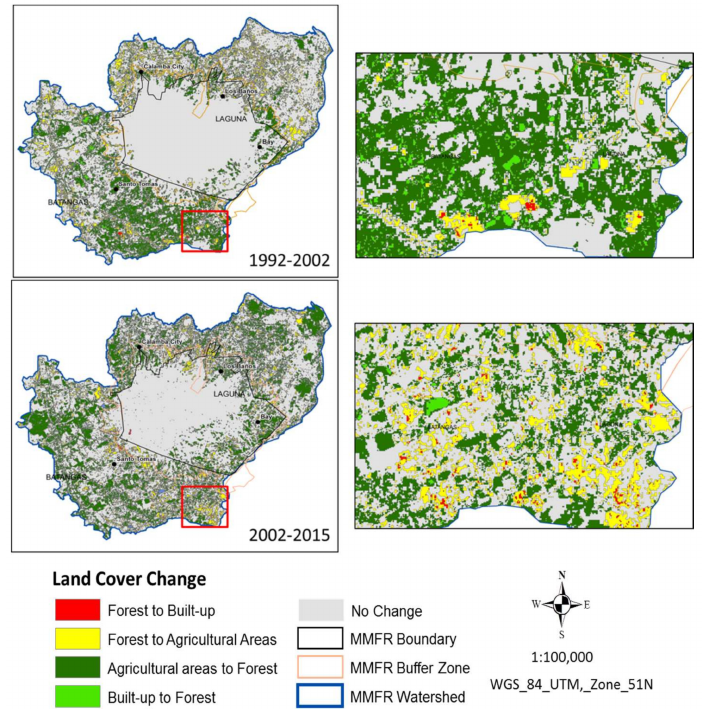
Figure 6. Change Maps of the MMFR Watersheds from 1992–2002 and 2002–2015. The two insets show the same zoomed area for its land cover